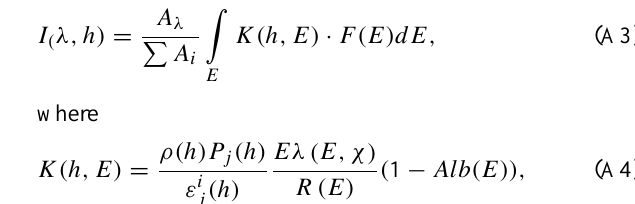
Fig. 9. The upper panel: examples of reconstruction of energy spec- tra. The lower panel: all dashed lines illustrate the energy spec- tra measured by the AE-C satellite on 21 March 1974 (Rees et al., 1977), the solid line indicates the reconstructed energy spectrum using experimental high profile of 381.4nm intensity (Sharp et al.,